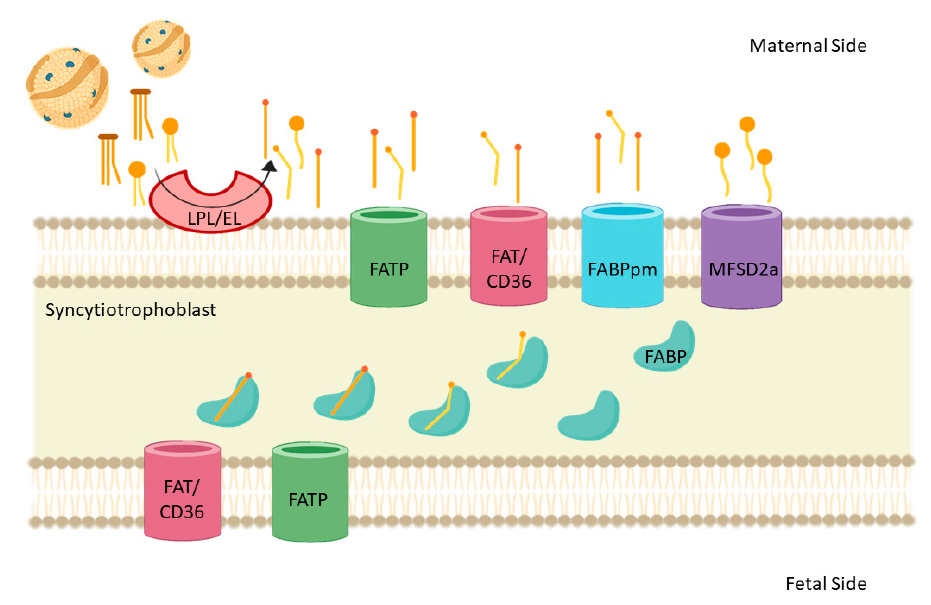
Figure 3. Schematic representation of placental fatty acid transport. Maternal triglycerides are hydrolyzed to non-esterified fatty acid (NEFA) by placental lipases (lipoprotein lipase (LPL) and endothelial lipoprotein lipase 9 (EL9). Then, the placenta can uptake and move the NEFA across the membrane through a flip-flop mechanism or with the help of binding proteins and transporters. FABP: fatty acid binding protein; FAT/CD36: fatty acid translocase; FATP: fatty acid transport protein; MFSD2a: main facilitator superfamily domain containing 2a; FABPpm: plasma membrane’s fatty acid binding protein.